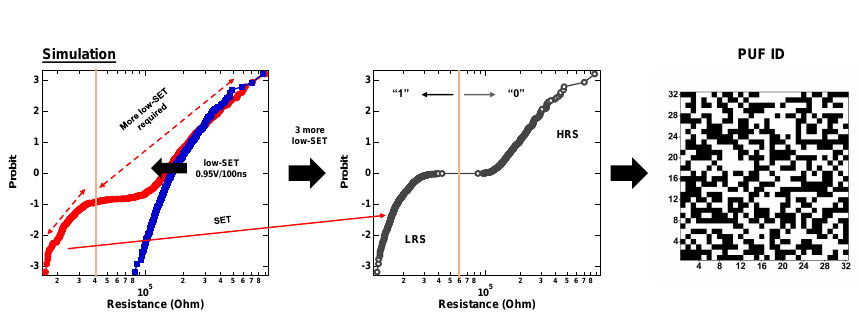
Figure 8: The PUF implementation method using multiple SET: (i) first applying a SET pulse aiming at under 50% of the population in LRS (ii) repeating the SET pulses until the population in LRS is sufficiently close to 50%. The threshold to determine SET failure is 40 kOhm.